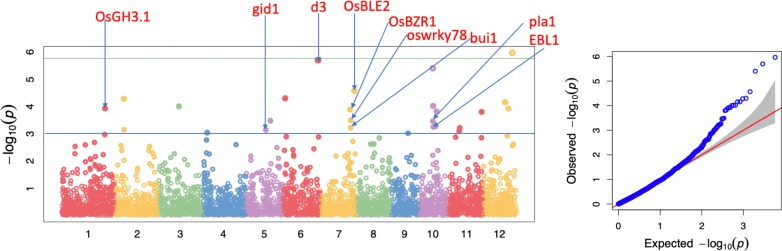
GWAS results for plant height using SNPs from the C7AIR.The manhattan plot shows the level of significance for SNPs correlated with plant height from the GWAS analysis (numbers across the x-axis indicate the chromosome). The Q-Q plot is shown at right. The blue line indicates the p <0.001 threshold and the green line indicates the Bonferroni correction threshold.